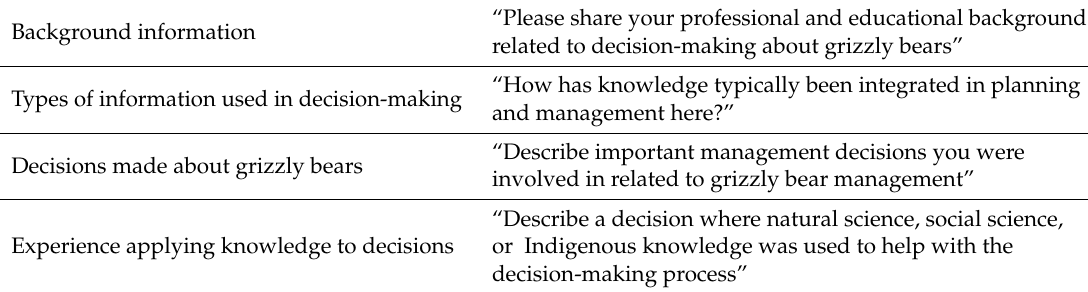
Table 2. Focus Group Guiding